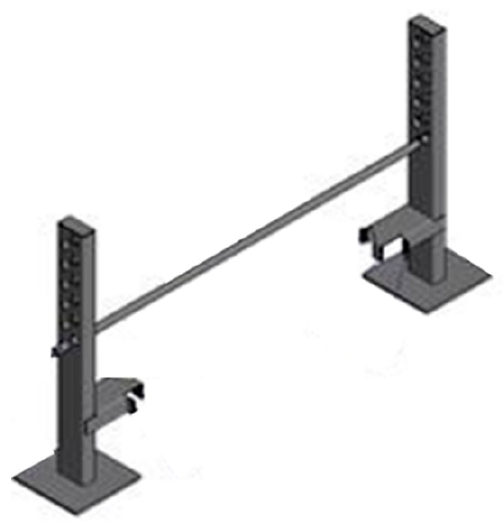
Figure 4. The mechanical safety pin system.